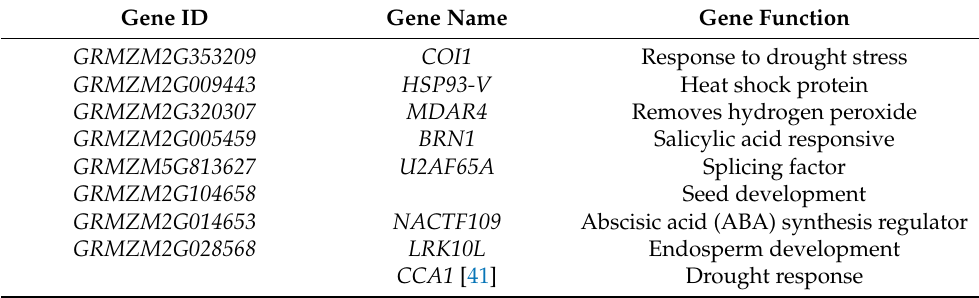
Table 1. Summary of splicing-associated genes